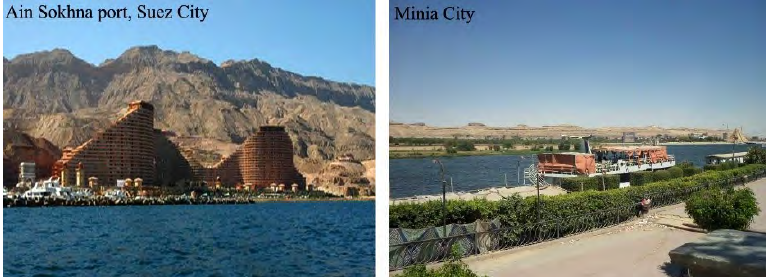
Figure 13. Ain-Sokhnah port Vs. Minya city, was recommended by experts forthe Earth-sheltered buildings’ application.